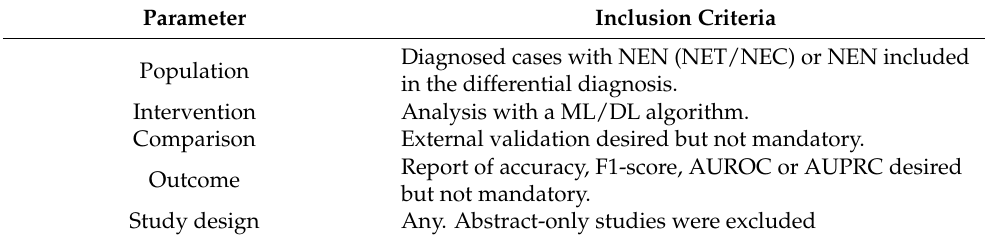
Table 1. Inclusion criteria. Parameter Inclusion Criteria Diagnosed cases with NEN (NET/NEC) or NEN included Population in the differential diagnosis. Intervention Analysis with a ML/DL algorithm. Comparison External validation desired but not mandatory. Report of accuracy, F1-score, AUROC or AUPRC desired Outcome but not